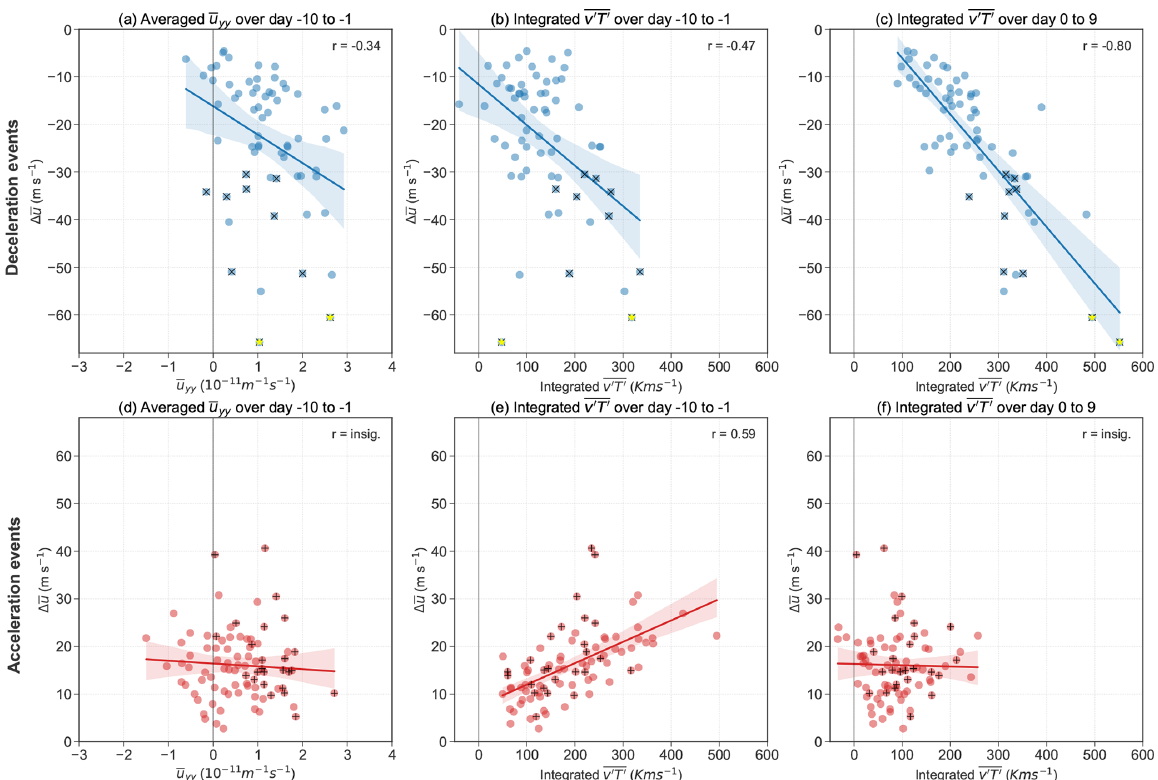
Figure 6. Relationship between the magnitude of the deceleration events ( (cid:49)u ) and (a) u yy averaged over days − 10 to − 1, (b) integrated v (cid:48) T (cid:48) over days − 10 to − 1 and (c) integrated v (cid:48) T (cid:48) over days 0 to 9. (d)–(f) Same as (a)–(c) but for the acceleration events. The marker “ × ” indicates SSW events, and “ + ” indicates strong vortex events. The solid line indicates the fitted linear regression line, and shading indicates the 95% confidence interval. Pearson correlation coefficients ( r ) are significant at 95% in all panels. Yellow asterisks (“ ∗ ”) in (a)–(c) denote the 2009 and 2018 split SSW